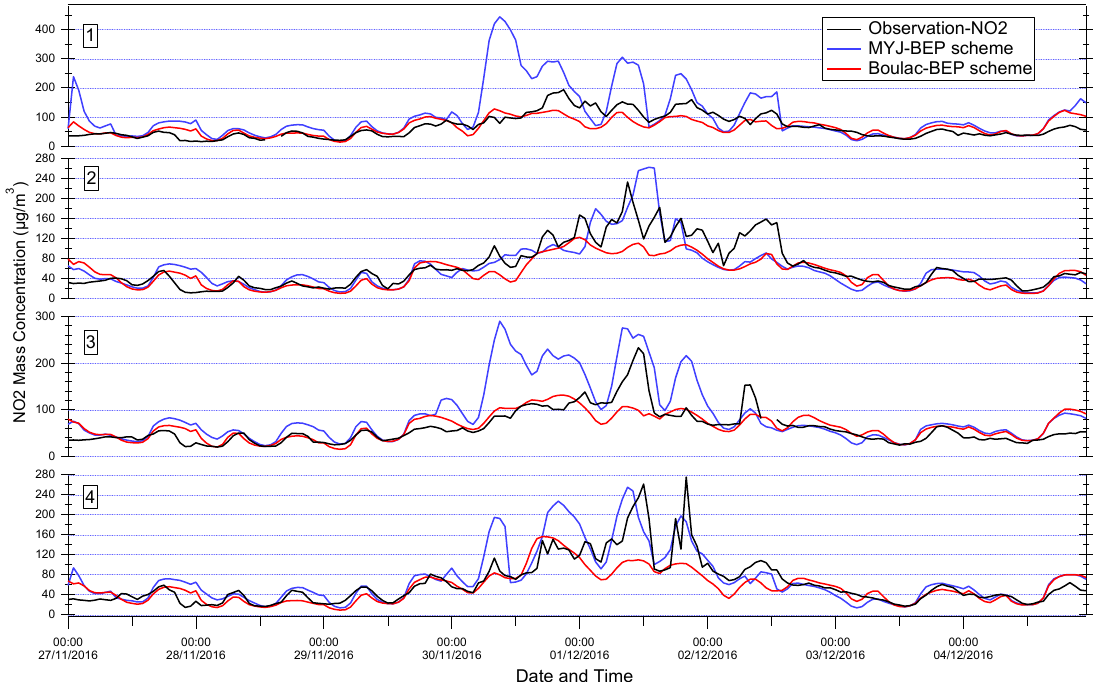
Figure 17. Time series of NO 2 mass concentrations: No 1, 2, 3, and 4 represent station FR04002, FR04034, FR04143, and FR04156, respectively.